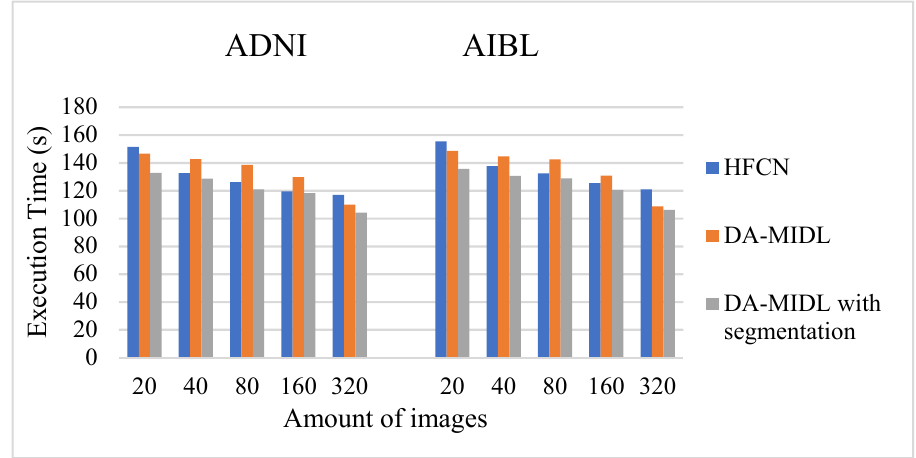
Figure 8. Execution time comparison outcomes between DA-MIDL, HFCN, and the proposed DA- MIDL with segmentation.